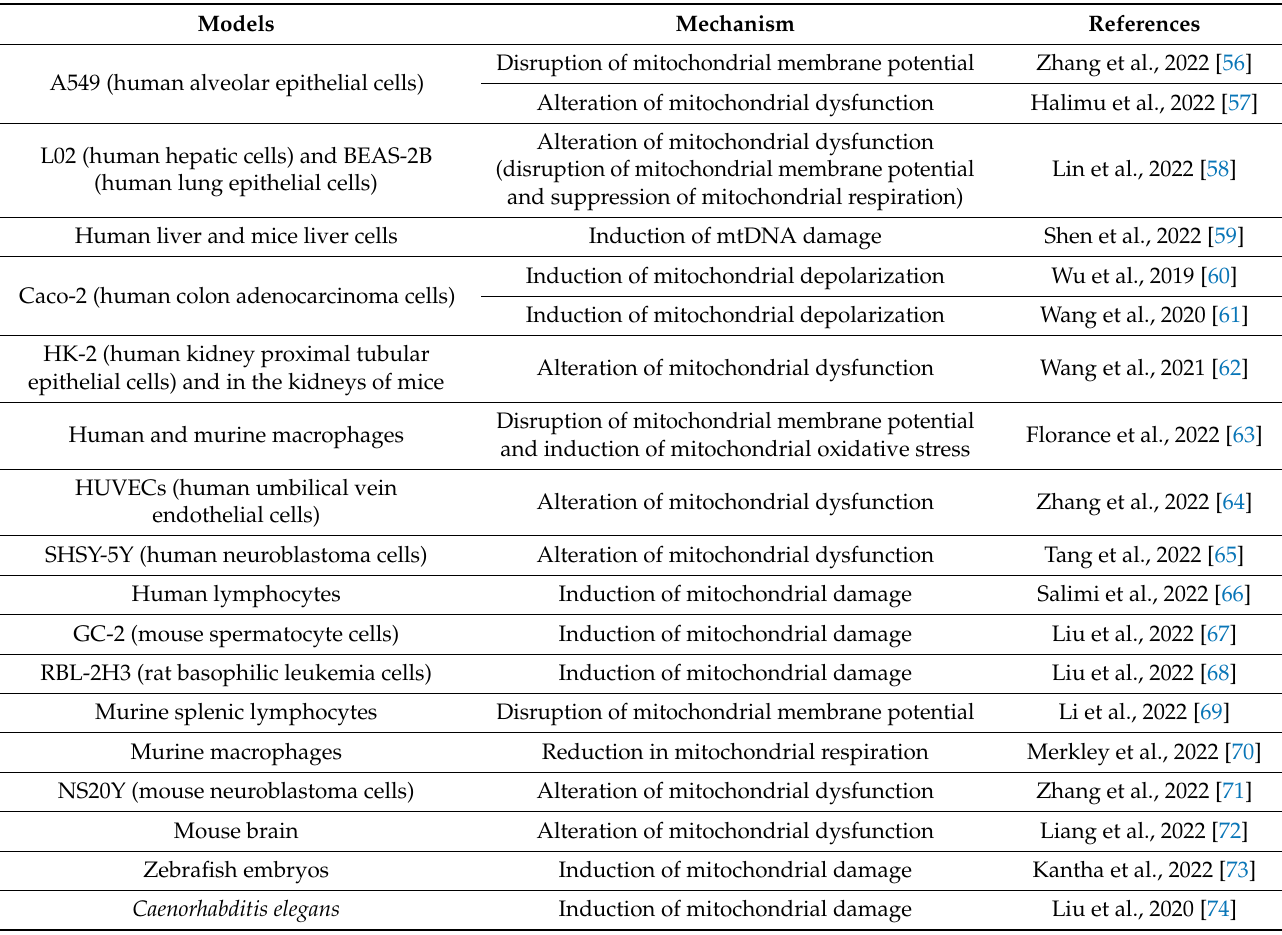
Table 1. Summary of micro- and nanoplastic (MNP) toxicity on